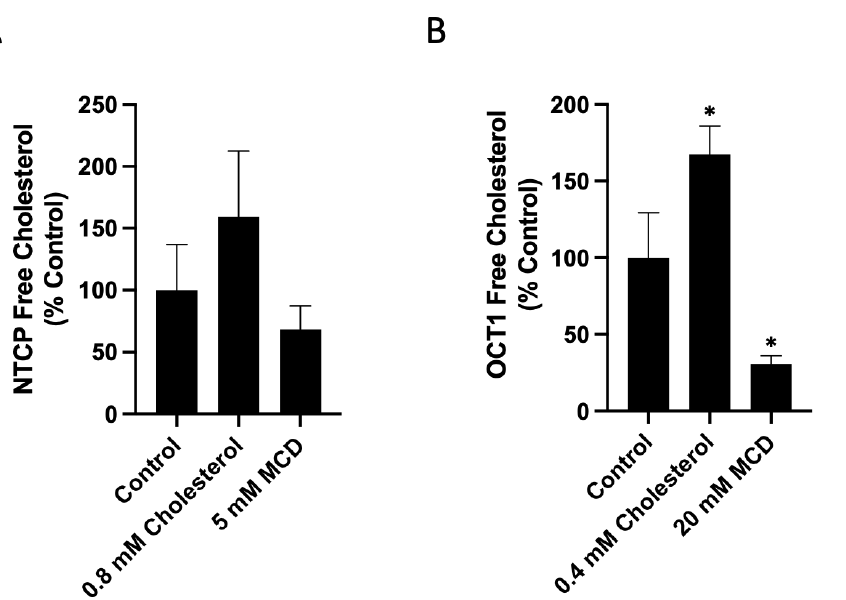
Figure 3. Free cholesterol content in transporter-expressing HEK293 cells. ( A ) NTCP- and ( B ) OCT1- expressing HEK293 cells were treated for 30 min with either Opti-MEM (control) or the indicated concentrations of cholesterol or MCD. The graphs represent the mean ± SD of 3 experiments for NTCP- and 4 experiments for OCT1-expressing cells; an asterisk indicates a p < 0.05 compared to the control group.